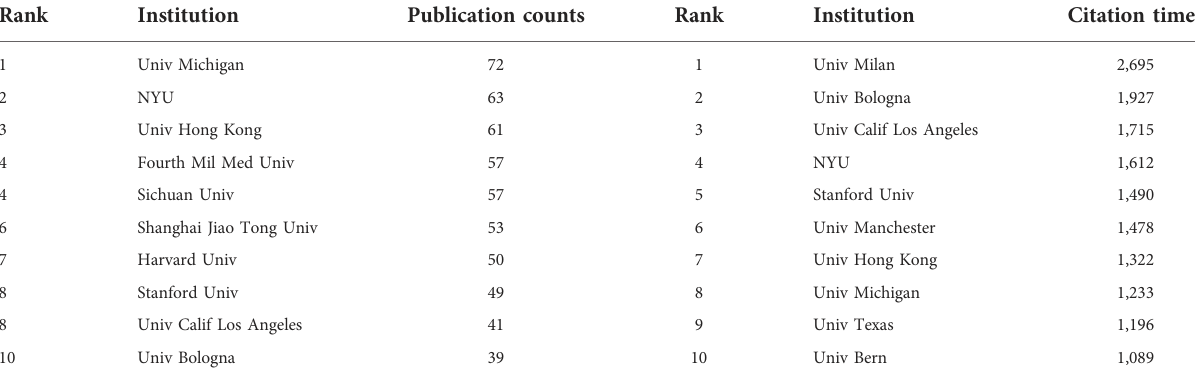
TABLE 2 The top 10 most productive and most cited institutions contributing to the research on craniomaxillofacial distraction osteogenesis from 2000 to 2021. Rank